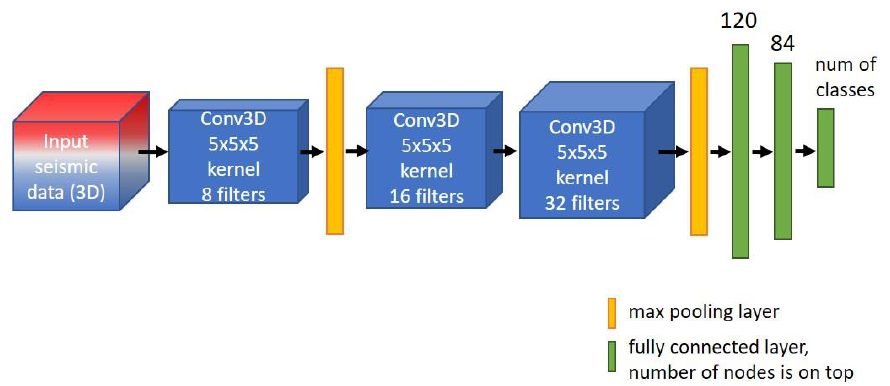
Figure 8. The 3D convolutional architecture. Based on [22]. ReLU activation was used after each convolutional and fully connected layer except the last one. The final activation was softmax. The input is 3D and the output is a single value (class index).